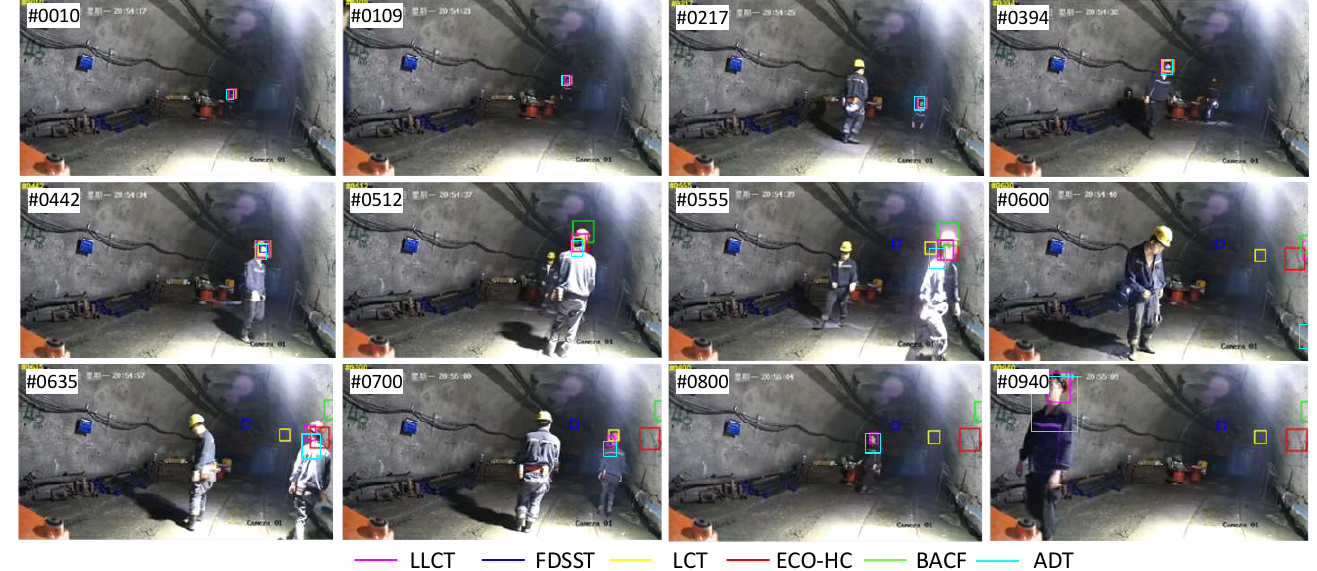
Figure 14. The qualitative experiment comparing the LLCT with state-of-the-art trackers in the coal mine roadway. The proposed method performed well in the coal mine environment. Table 4. The quantitative performance of the field experiment.